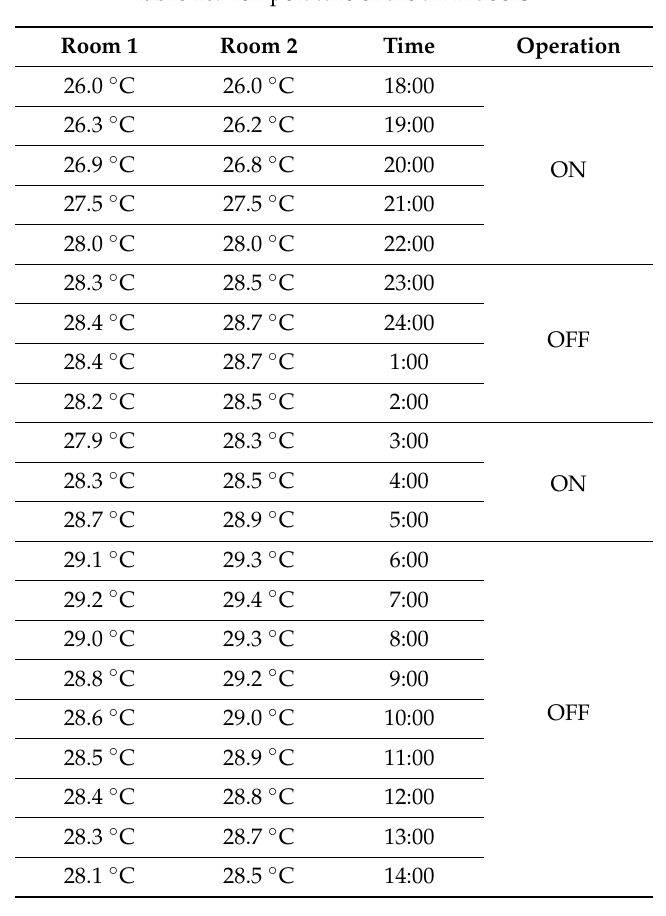
Figure 13. Change in room air temperature over time. Table 10. Temperature of the air